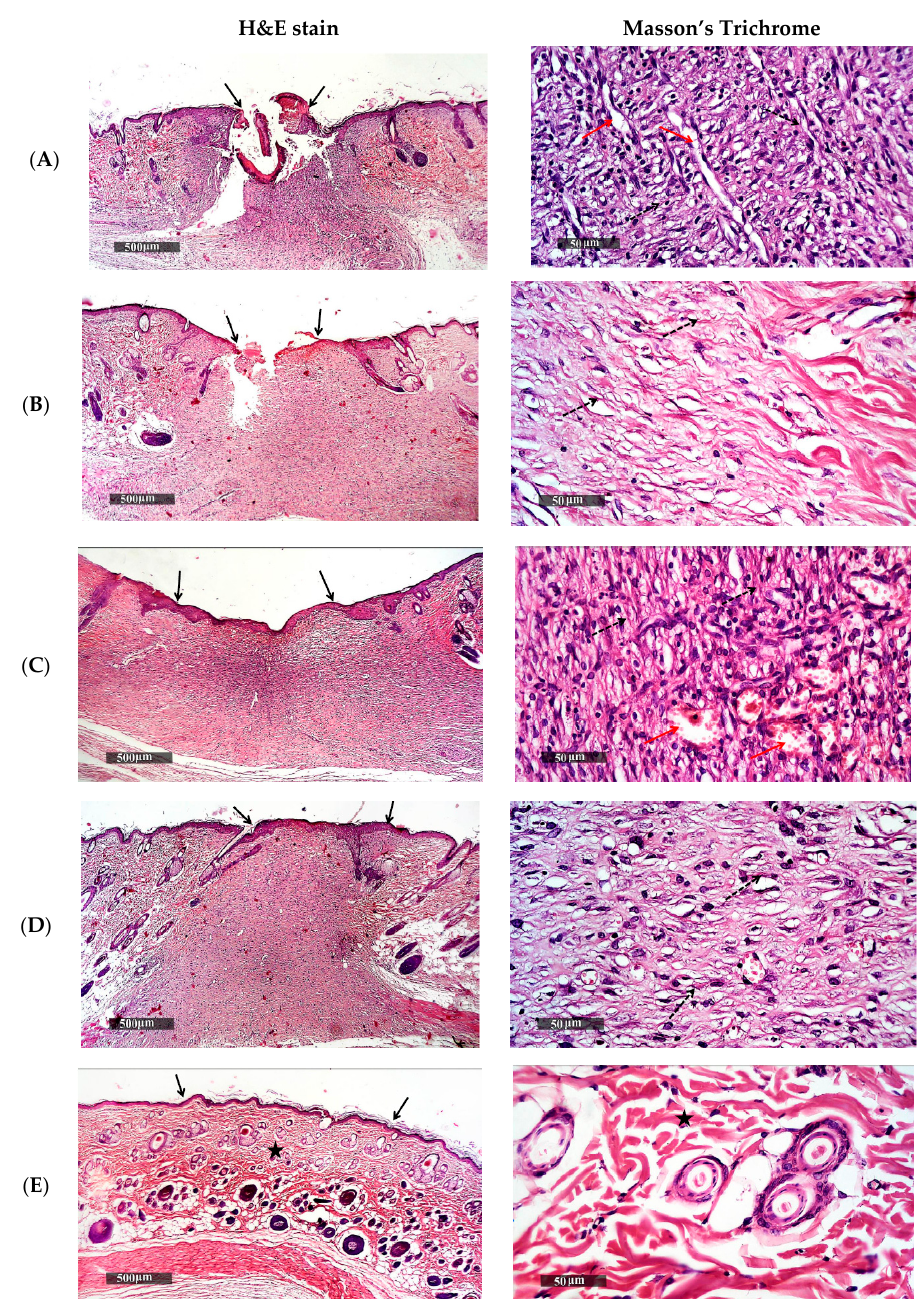
Figure 10. Histopathological microscopical examination section of the non-treated control group ( A ); treated group with NVH suspension ( B ); treated group with blank chitosomal formulation ( C ) and treated group with NVH-loaded chitosomal formulation ( D ), and normal control sample skin ( E ).